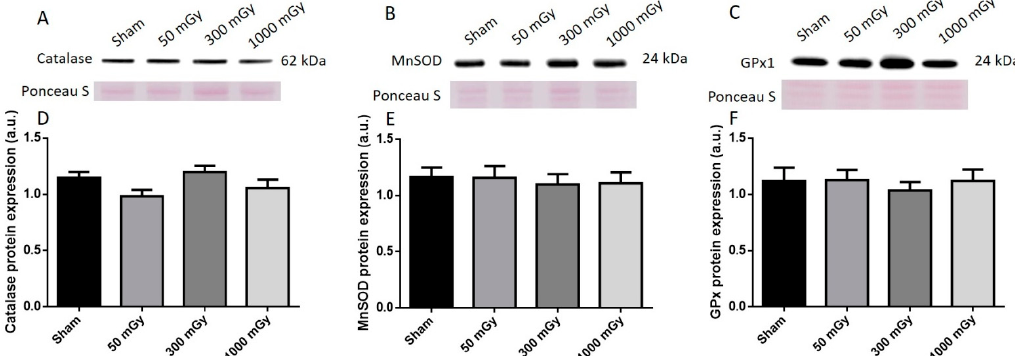
Figure 9. Representative western blot ( A – C ) and quantified band density ( D – F ) (relative protein expression in arbitrary units) for ( A ) catalase, ( B ) manganese superoxide dismutase (MnSOD), and ( C ) glutathione peroxidase 1 (GPx1) in male offspring cardiac tissues. Results were normalized to loading controls (samples repeated on each gel) to account for differences between gels, and Ponceau S staining was used as a marker of equal protein loading. Data are presented as a mean ± SEM. n = 11–13 per group.